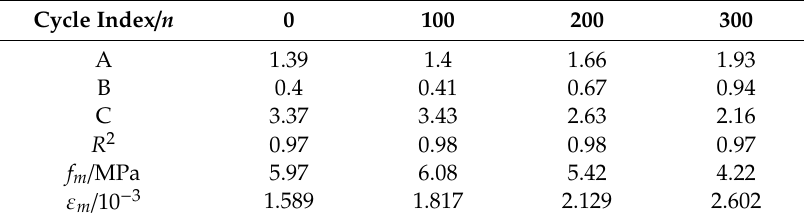
Table 9. Fitting parameters of stress-strain curves.